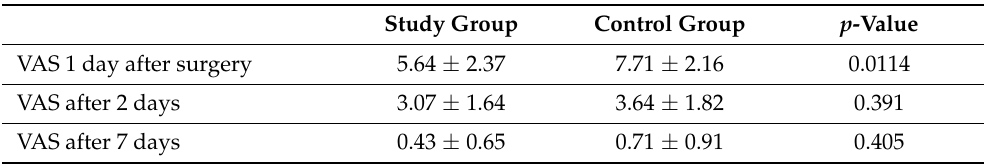
Table 4. Comparison of pain intensity according to the VAS—visual analog scale in the test group (n = 15) and the control group (n = 15). Study Group Control Group p